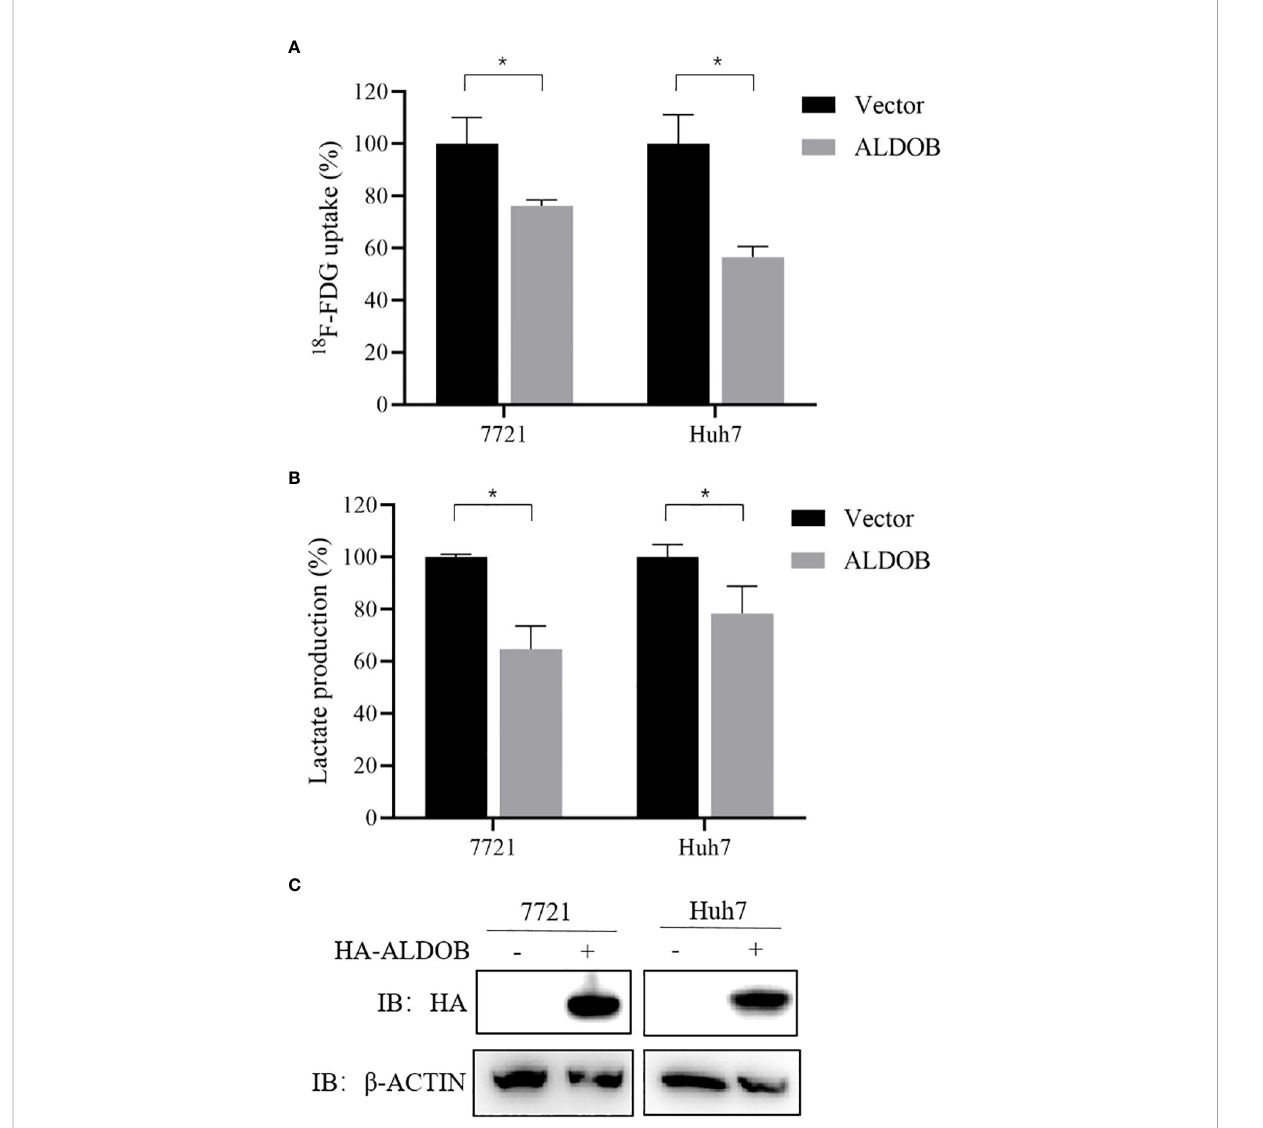
FIGURE 5 In fl uence of ALDOB overexpression on 18 F-FDG uptake and lactate production in HCC cells (7721 and HuH7 cell lines). (A) ALDOB overexpression signi fi cantly inhibited 18 F-FDG uptake in 7721 and HuH7 cells (P=0.017 and P=0.003). (B) ALDOB overexpression signi fi cantly inhibited lactate production in 7721 and HuH7 cells (P=0.013 and P=0.011). (C) HA-tag ALDOB and HA-VECTOR were transfected in 7721 and HuH7 cells, after 48h, the cells were lysed and protein expressions were veri fi ed by western blotting. *P values<